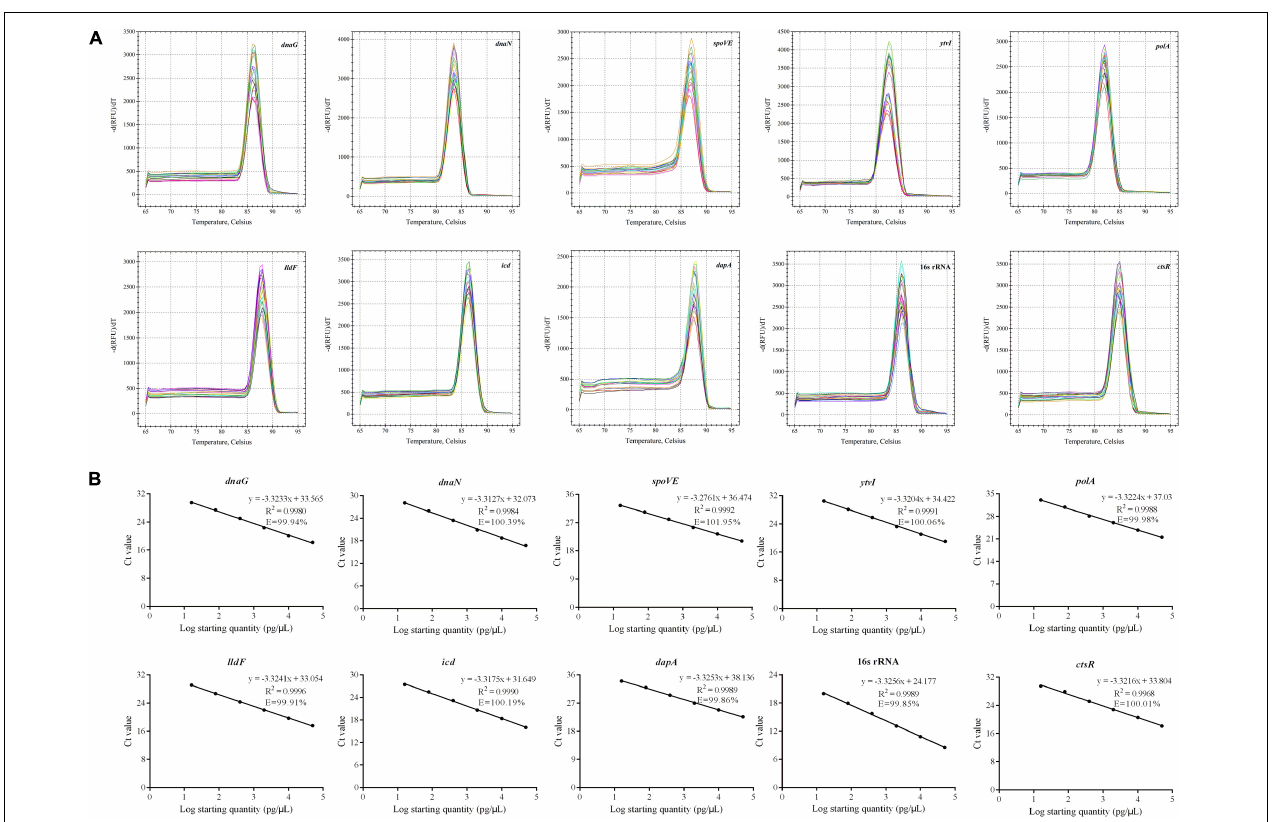
FIGURE 3 | Confirmation of the primer amplification specificity and efficiency of candidate reference genes and target gene. (A) Melting curve analysis; (B) standard curves showing the correlation between the copies and the quantification cycle ( C q)